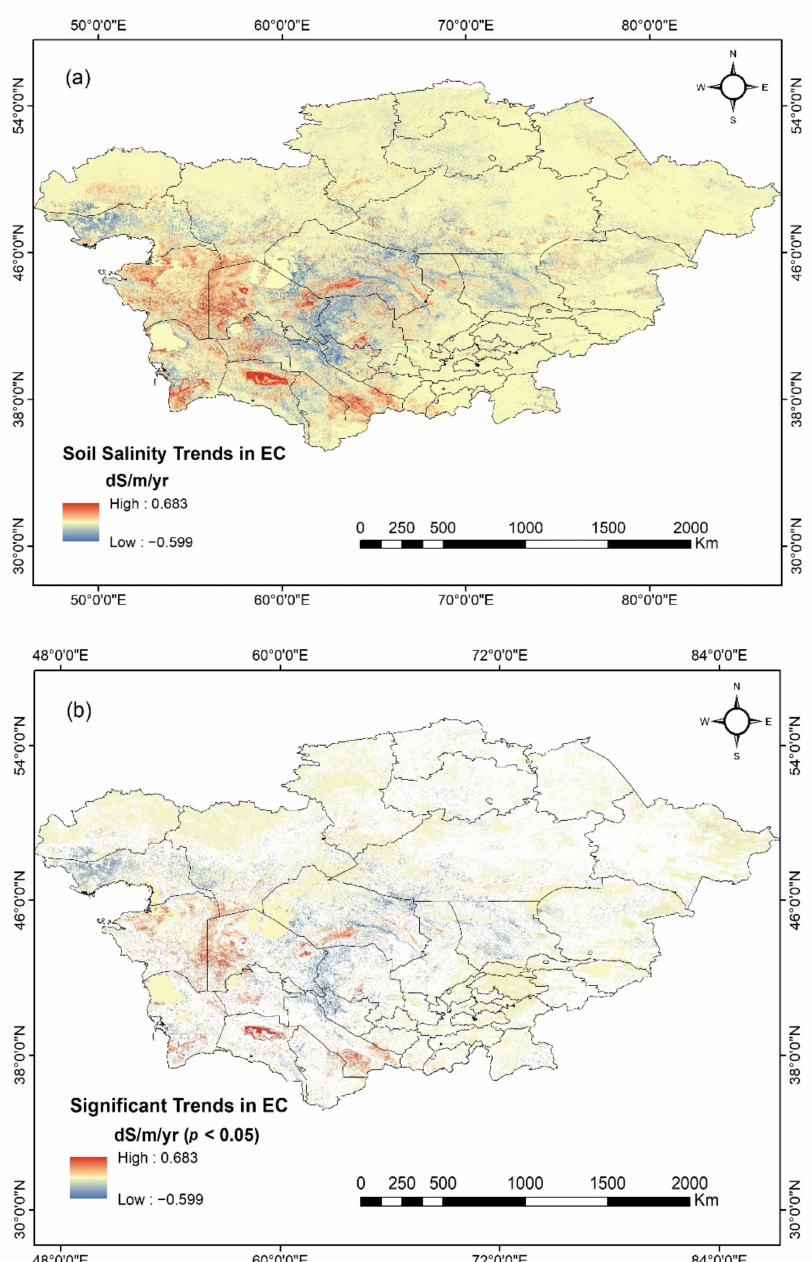
Figure 5. ( a ) Soil EC annual trend and ( b ) trend with p < 0.05 over Central Asia during